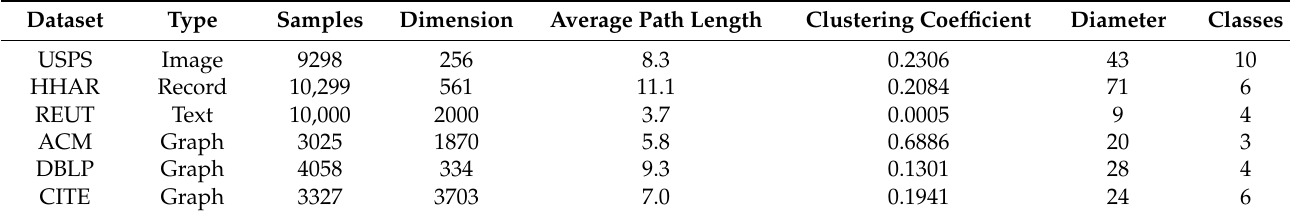
Table 1. The details of the